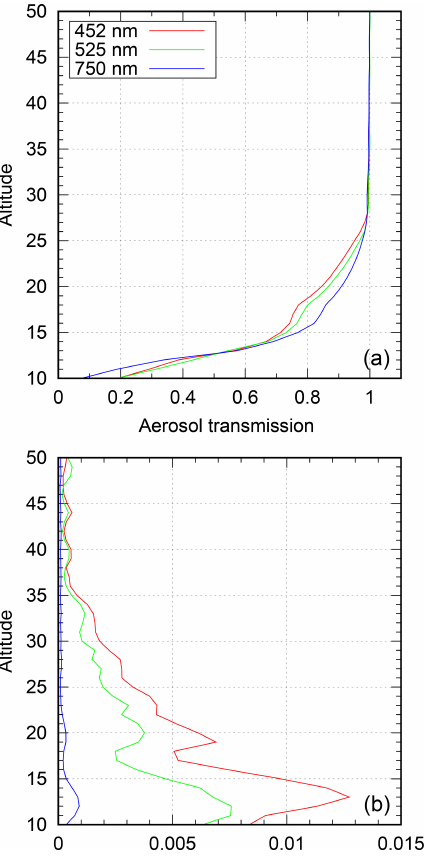
Figure 7. Aerosol transmissions (a) and corresponding errors (b) for orbit 8014 (11 September 2003) and different wavelengths.